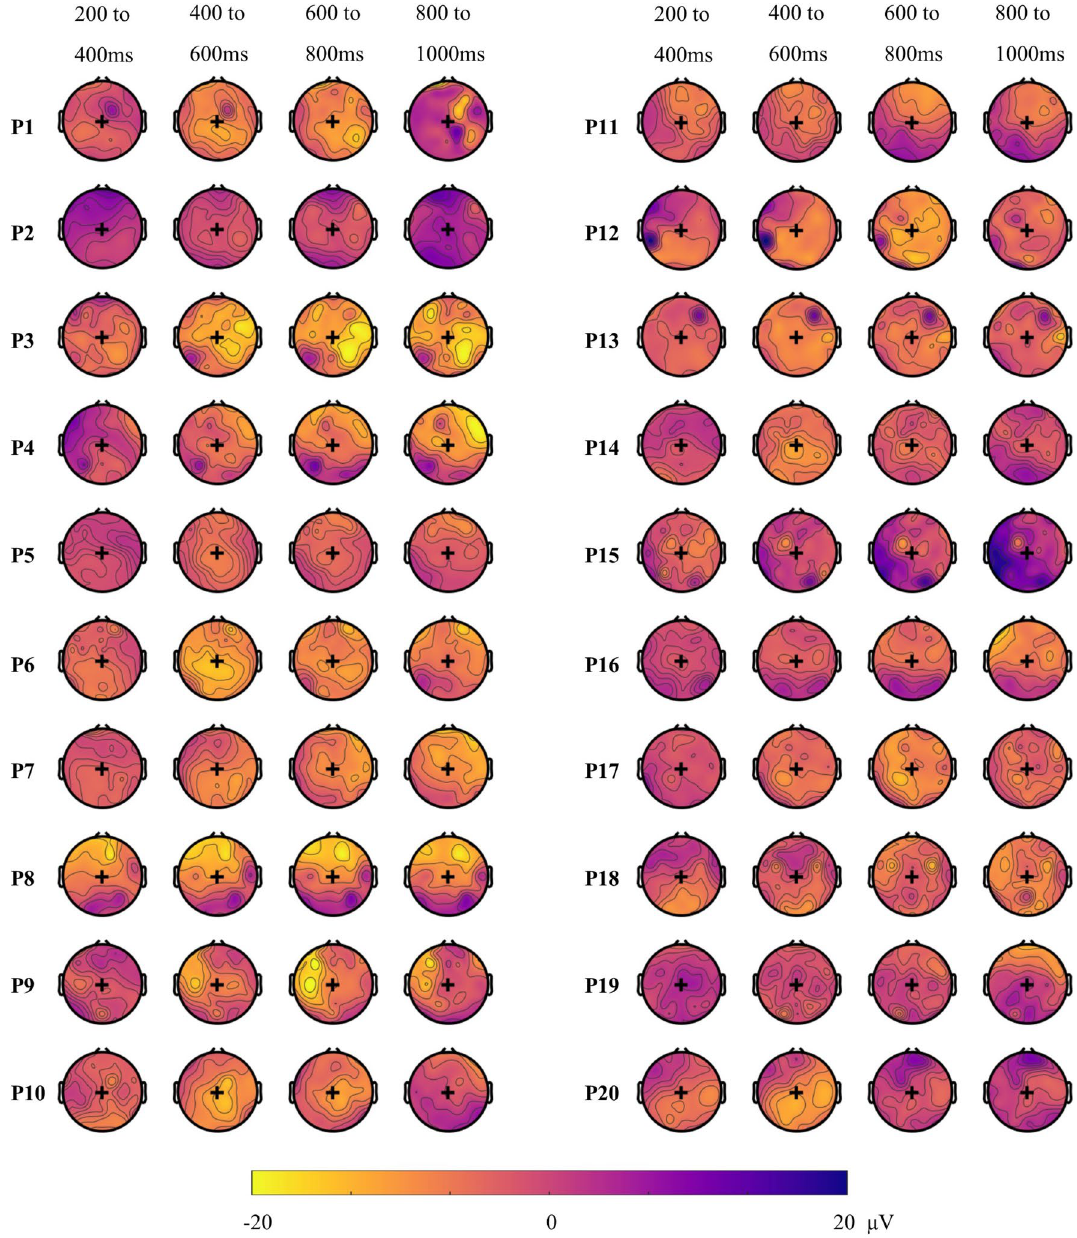
Figure 7. Individual topographic maps of the N400 effect (unrelated minus related condition) for 200 ms time windows from 200 to 1,000 ms after target onset. Yellow colours indicate a negative difference between the two conditions (incongruent more negative than congruent), while blue colours indicate a positive difference. These maps are for illustrative purposes and are not thresholded for significance. Back + indicates Cz location. The topography of the N400 effect varied across individuals. P indicates participant, with participant numbering as in Fig.